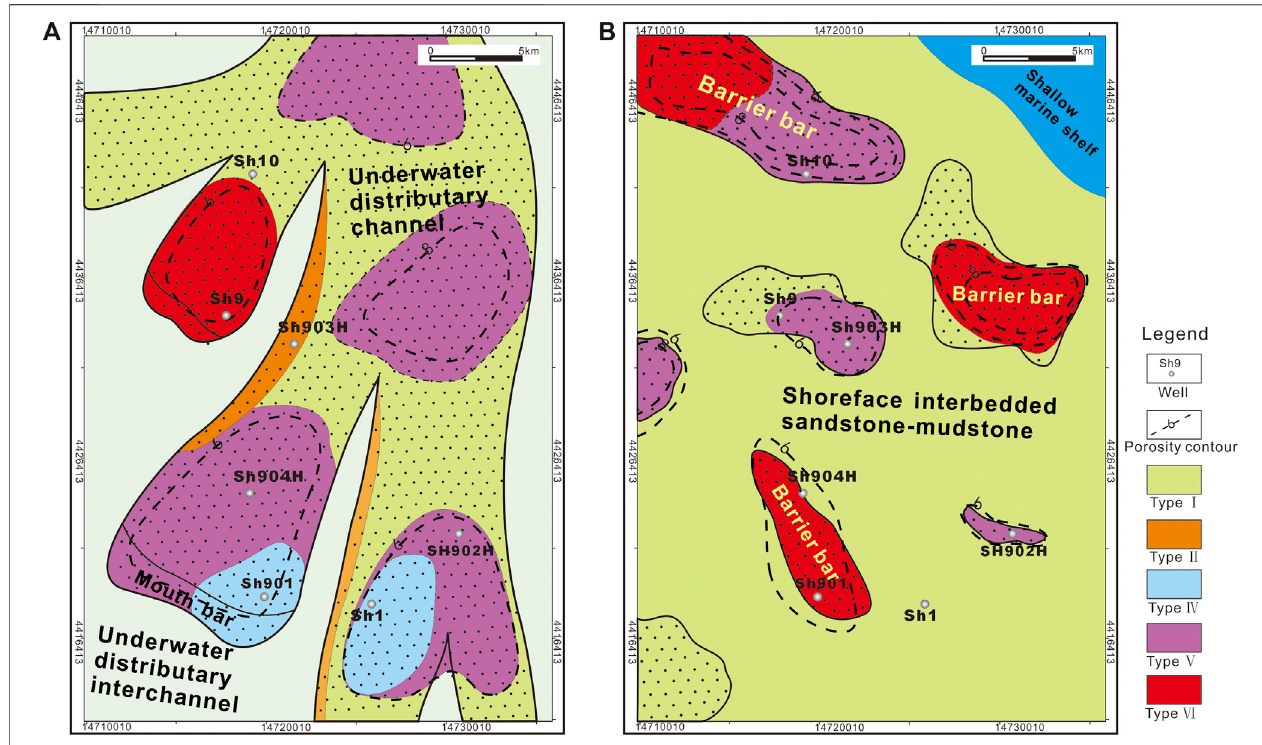
FIGURE 9 | Distribution of diagenetic facies in Kepingtage Formation (a. S 1 k 3 . B . S 1 k 1 .). (Diagenetic facies boundaries are dotted lines representing the approximate range of distribution, and distribution is based on dominant diagenetic facies in single Well identi fi cation and the distribution refers to the sedimentary microfacies. Plane map of sedimentary microfacies are modi fi ed after Sun et al., 2013. Porosity contour is mapped according to the plane map of seismic porosity).